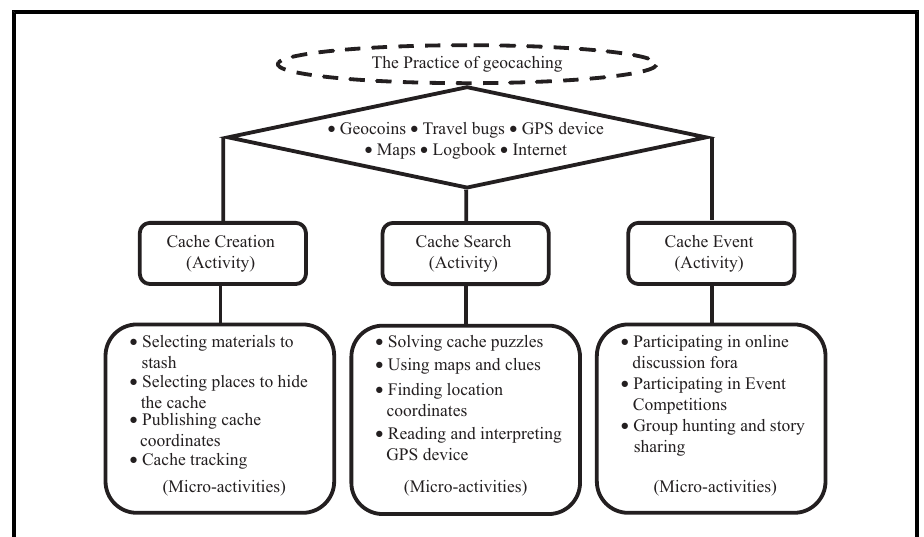
Figure 1 The practice of geocaching